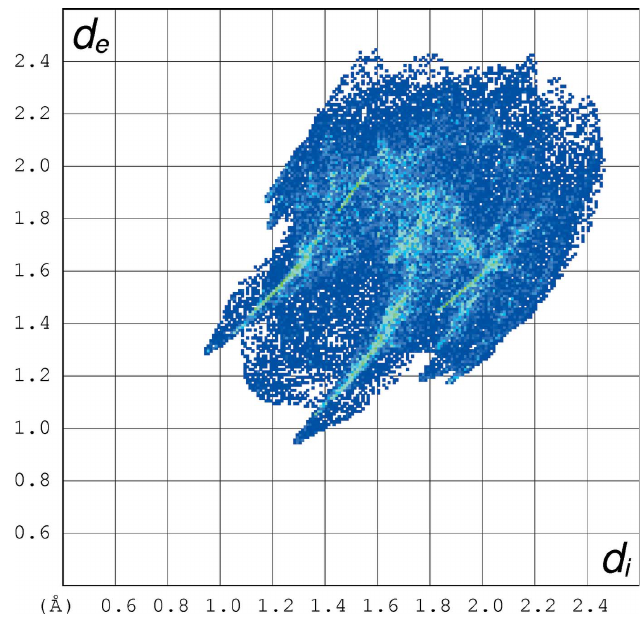
Figure 6 Hirshfeld fingerprint plot for (II)